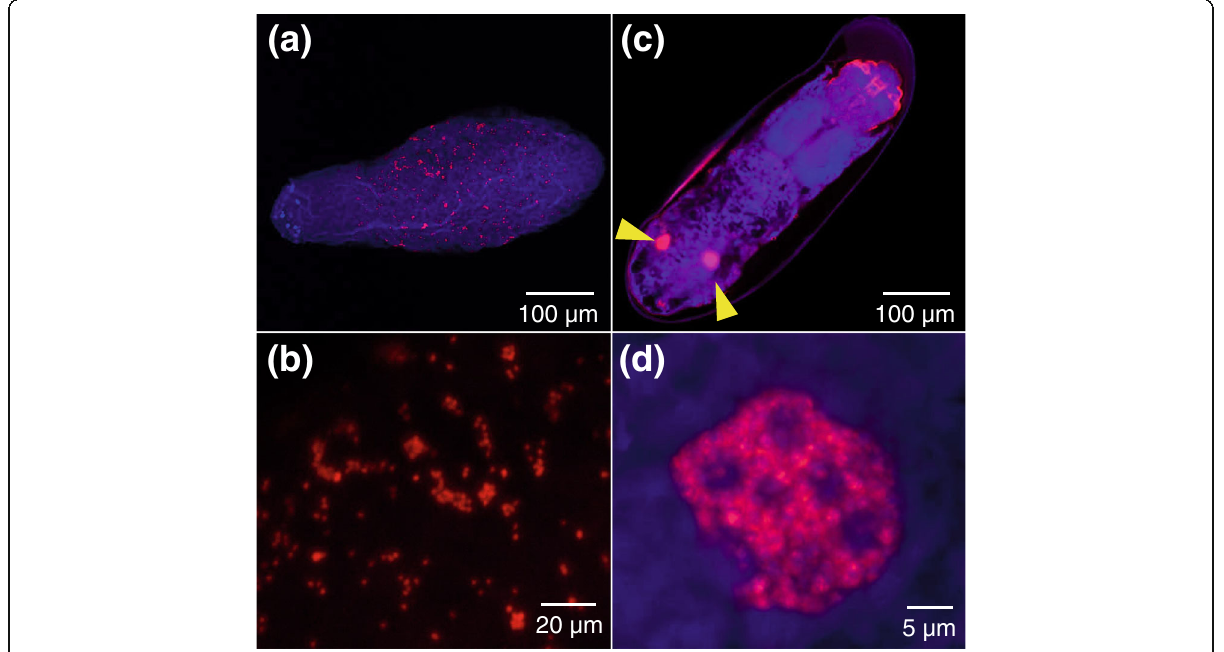
Fig. 6 Localization of symbiotic bacteria in egg and embryo of R. dominica . a An egg, in which scattered symbiont signals are visible. b An enlarged image of the symbiont signals. c A late embryo, in which a pair of bacteriomes is already formed in the abdomen. d An enlarged image of the embryonic bacteriome. Symbiont 16S rRNA is visualized by fluorescence in situ hybridization in red, while DNA is counterstained in